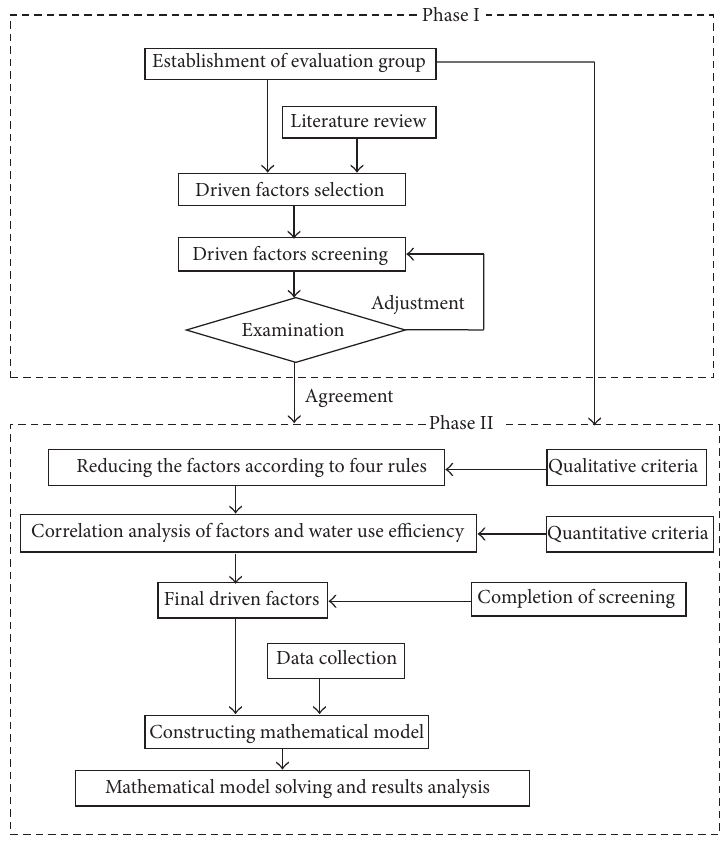
Figure 2: Screening and classification process chart of driven